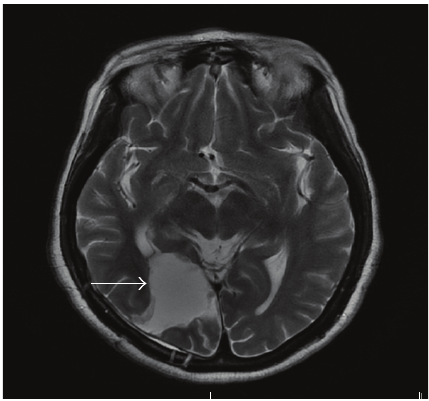
Figure 1: T2-weighted cranial MRI showed a 4.5 × 4.1 × 6.2-cm solitary BM (white arrow) in the right parietal-temporal-occipital lobe with intense contrast enhancement and a 0.8 cm displacement of midline structures. The lesion also compresses occipital horn of the lateral ventricle posteriorly and is surrounded by a wide area with alteration of signal that could correspond to edema or tumor